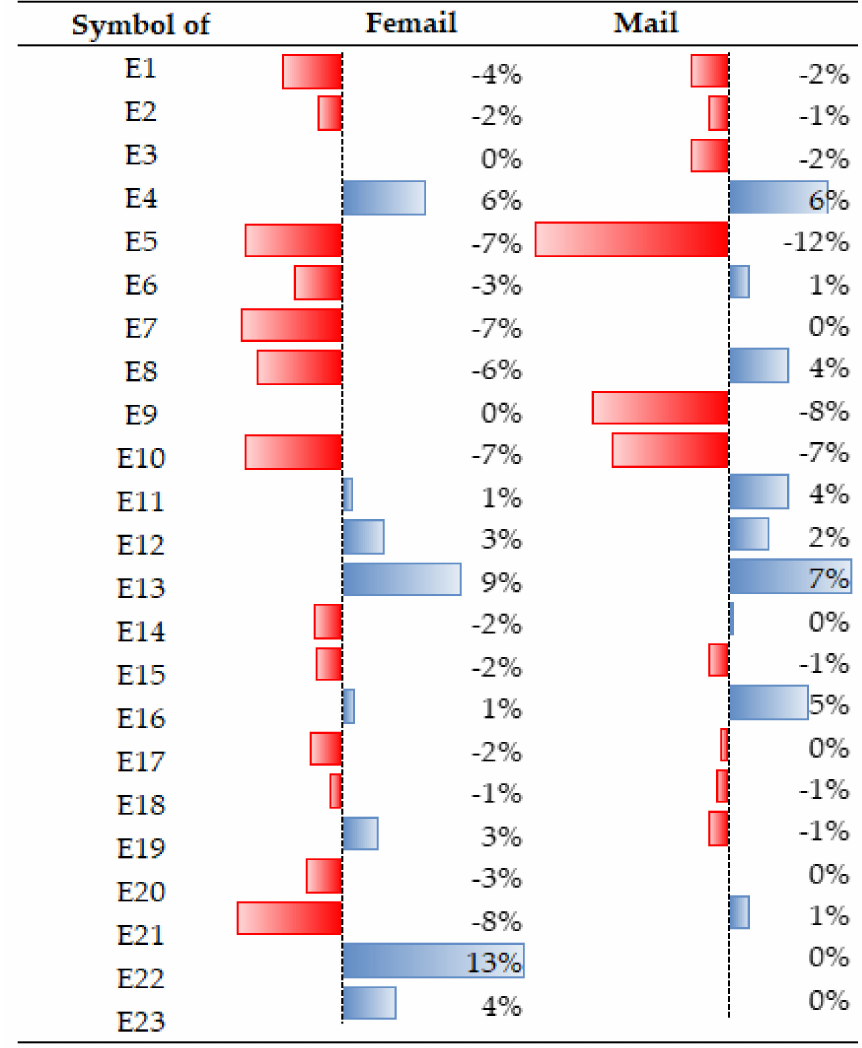
Figure 5. Differences in the perception of external factors, broken down by gender. Source: own